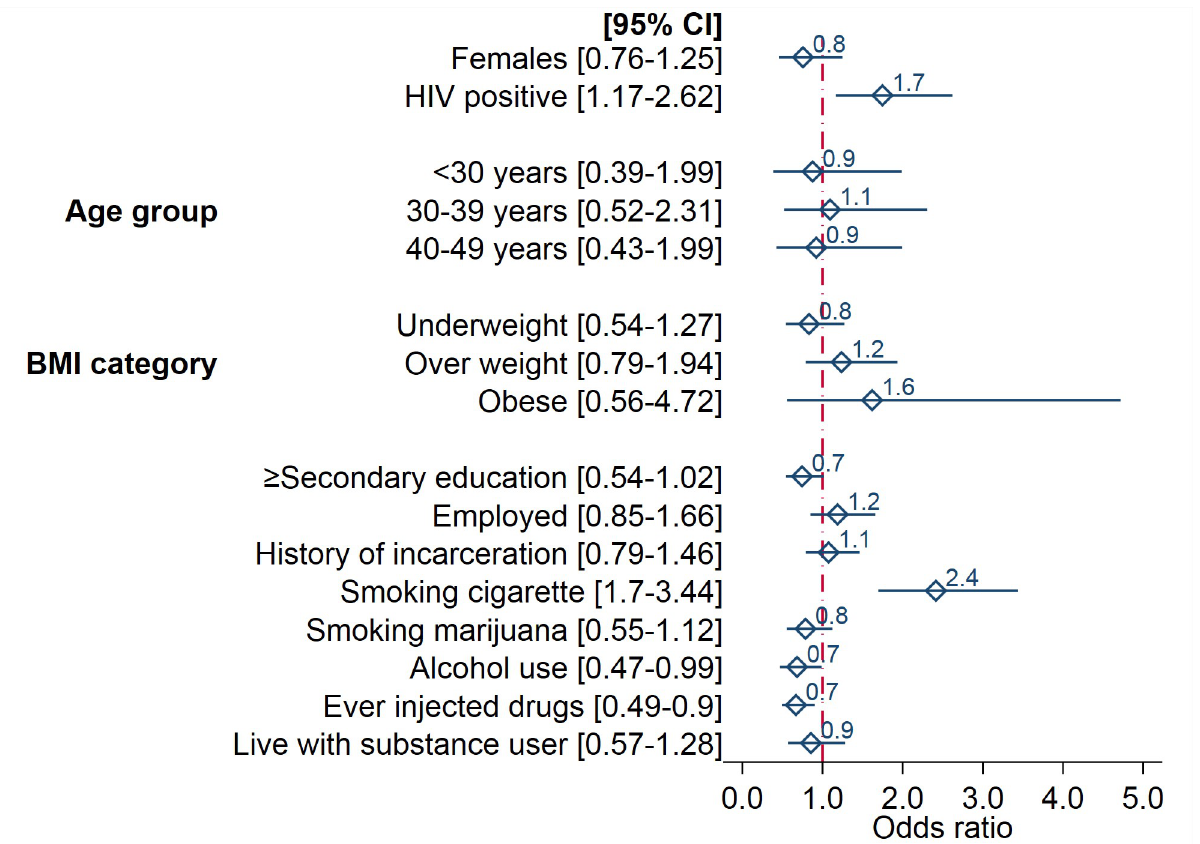
Fig 2. Risk factors of TB infection among people receiving medication-assisted treatment for substance use disorder in Dar es Salaam, Tanzania; adjusted logistic model (n = 823).